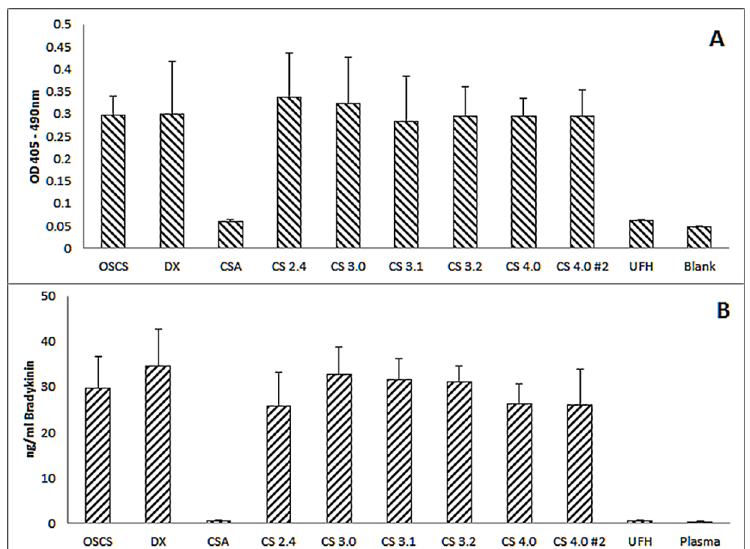
Fig 2. Kallikrein and Bradykinin levels obtained from a defined quantity of synthetic and purified OSCS, native chondroitin sulfate, dextran sulfate and unfractionated heparin. Different amounts of each material, predicted to generate the same level of (A) kallikrein as determined by optical density increase and (B) bradykinin, were used (see Table 4). No statistical difference was observed between the samples (oneway ANOVA, p = 0.883 and 0.568 respectively). CS-A and UFH were included at 100 μ g/ml, the highest level used. Error bars = standard deviation; n = 6.